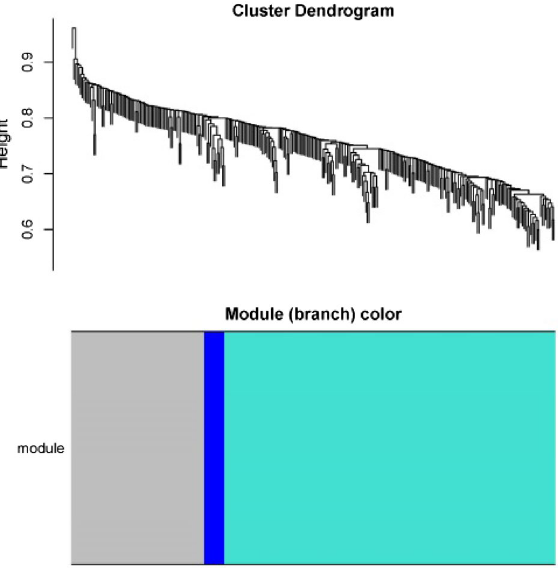
Figure 2. Gene modules. Three gene modules of MEturquoise, MEblue and MEblue were obtained. The MEturquoise is the hub module.